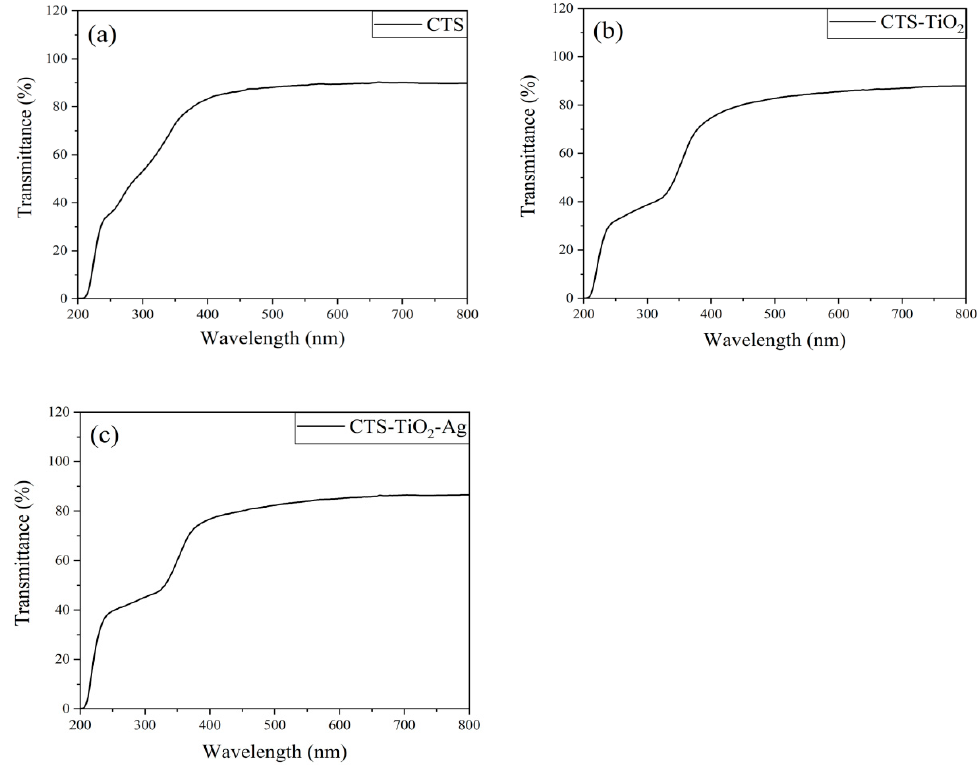
Figure 3. The transmittance of three films: ( a ) CTS single membrane; ( b ) CTS-TiO 2 composite membrane; ( c ) CTS-TiO 2 -Ag composite membrane.